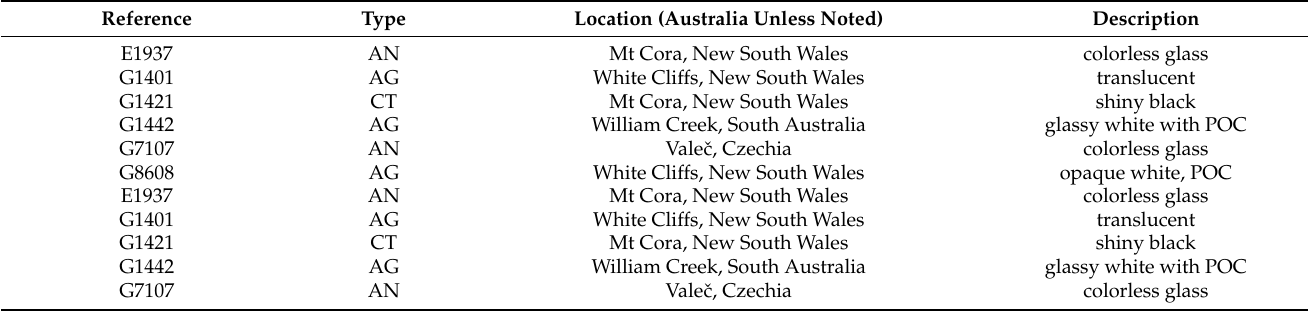
Table A1. Sample Data: As Labelled on